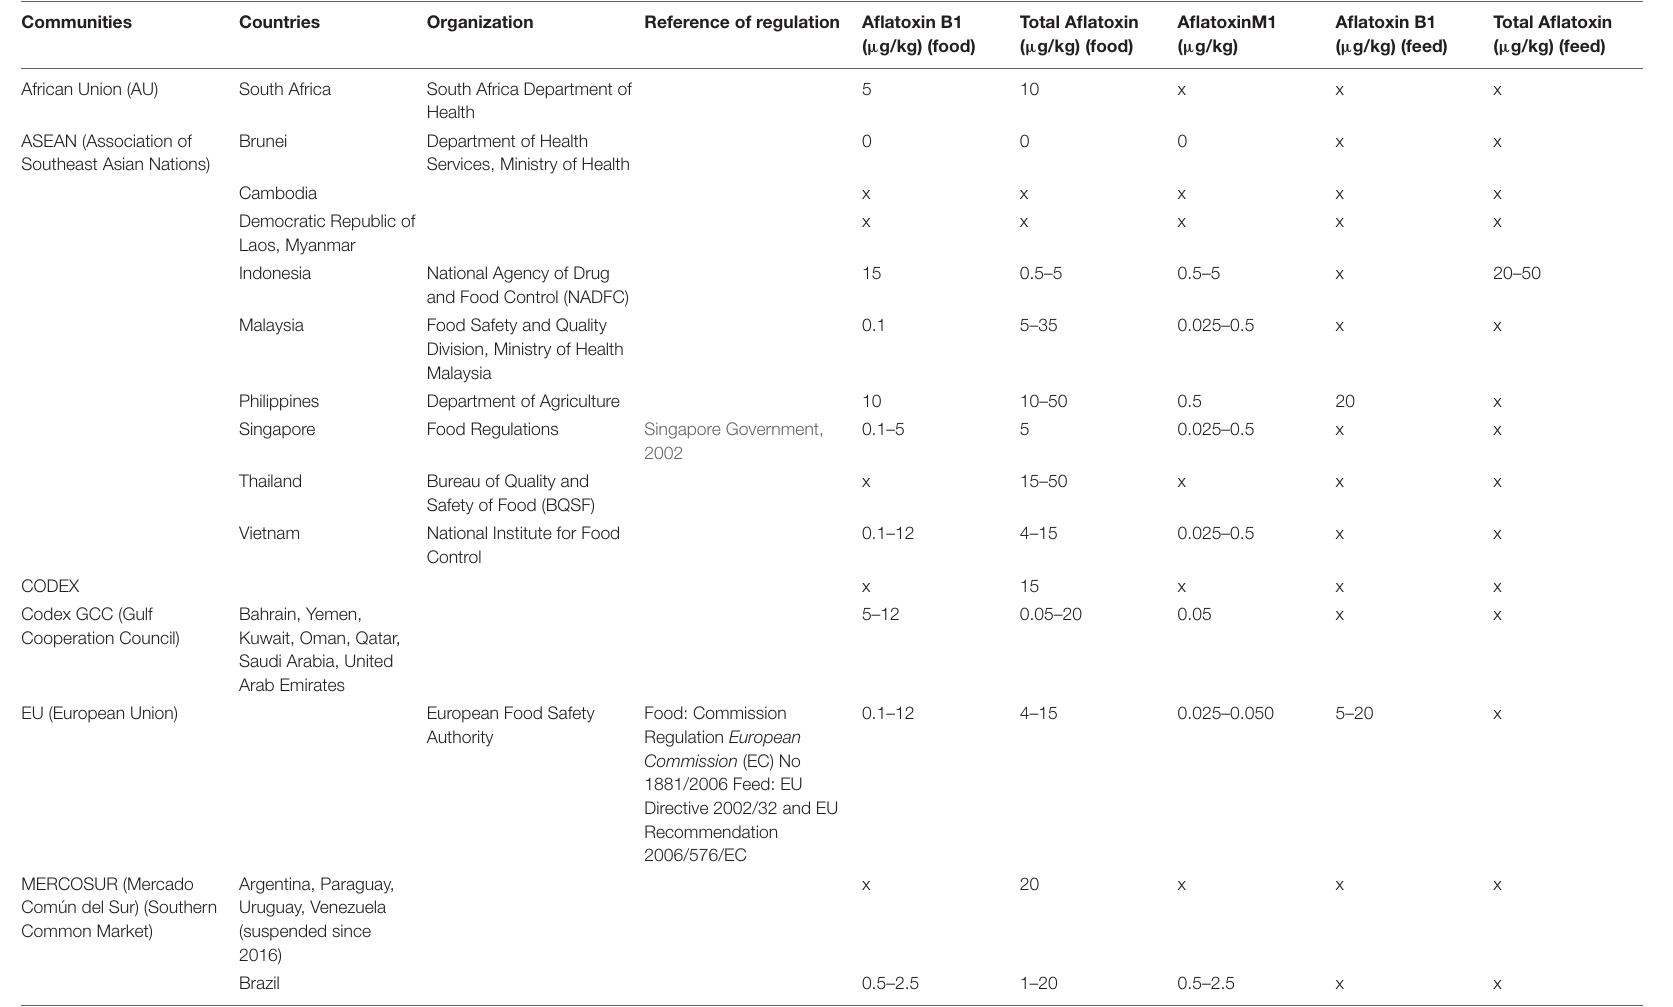
TABLE 1 | Worldwide aflatoxin regulations, allowed maximum